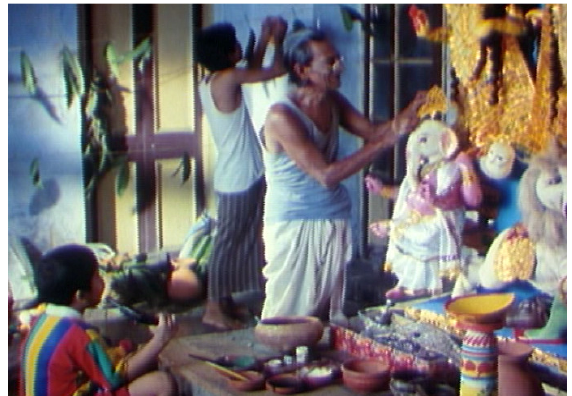
Figure 7. Bumba and Banshida, screen grab, Utsab